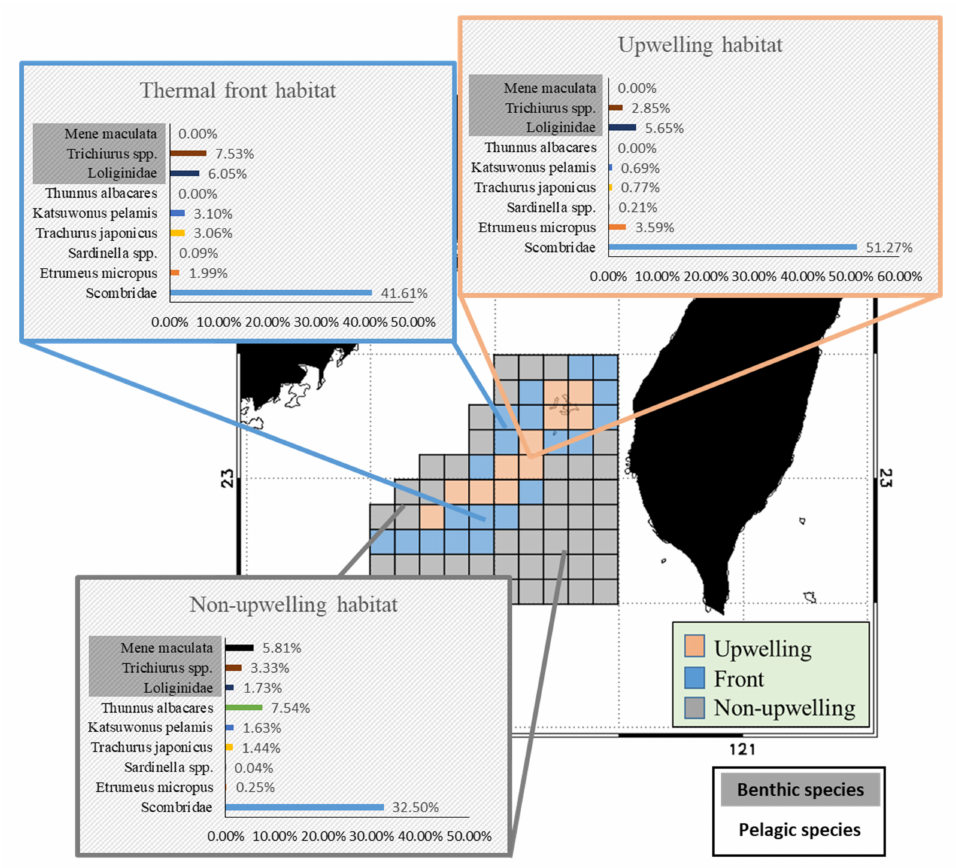
Figure 6. The important species with the contributions to primary production required in the three